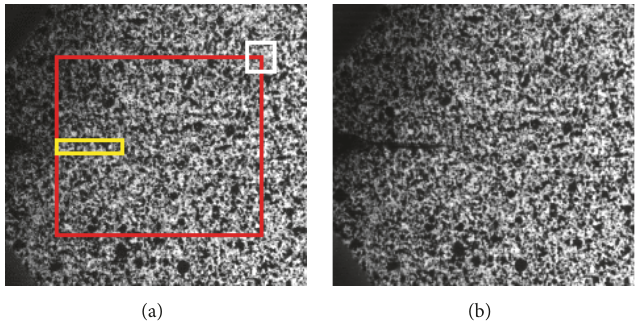
Figure 7: (a) The ROI in the reference image; (b) target